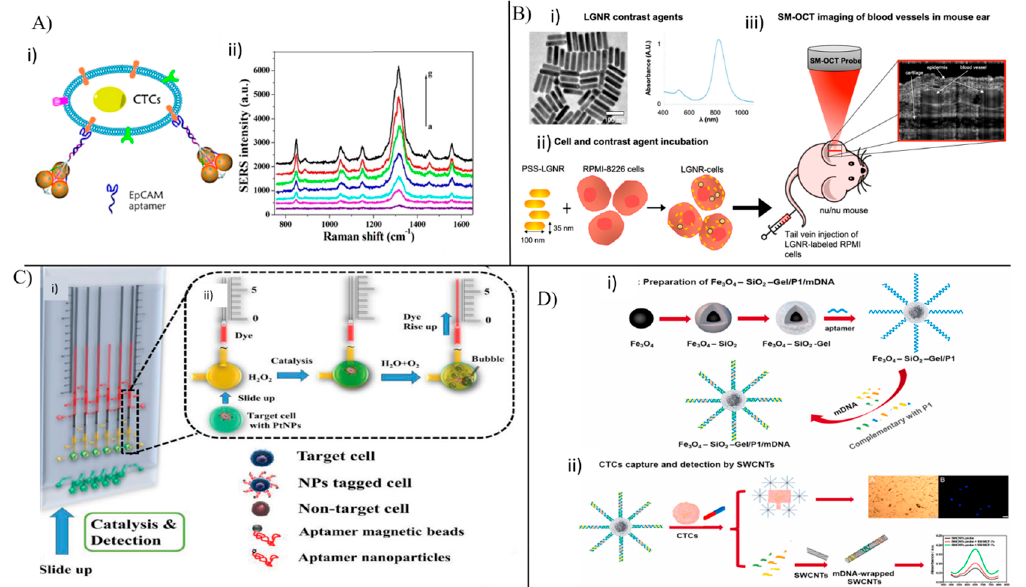
Figure 8. CTC detection techniques ( A ) (i) Tetrahedron–AuNP aptamer nanoprobes assembly for detection of CTCs through (ii) SERS spectral analysis (reproduced with permission from [128]). ( B ) Optical coherence tomography (OCT) using (i) poly(sodium 4-styrenesulfonate) (PSS)-modified large gold nanorods (LGNRs) for (ii) CTC detection using speckle-modulating OCT (SM-OCT) imaging demonstrated in (iii) a mouse ear (reproduced with permission from [129]). ( C ) Operation of volumetric bar chip (reproduced with permission from [130]) and ( D ) CTC capture and detection of mDNA through colorimetric quantifications (reproduced with permission from [131]).